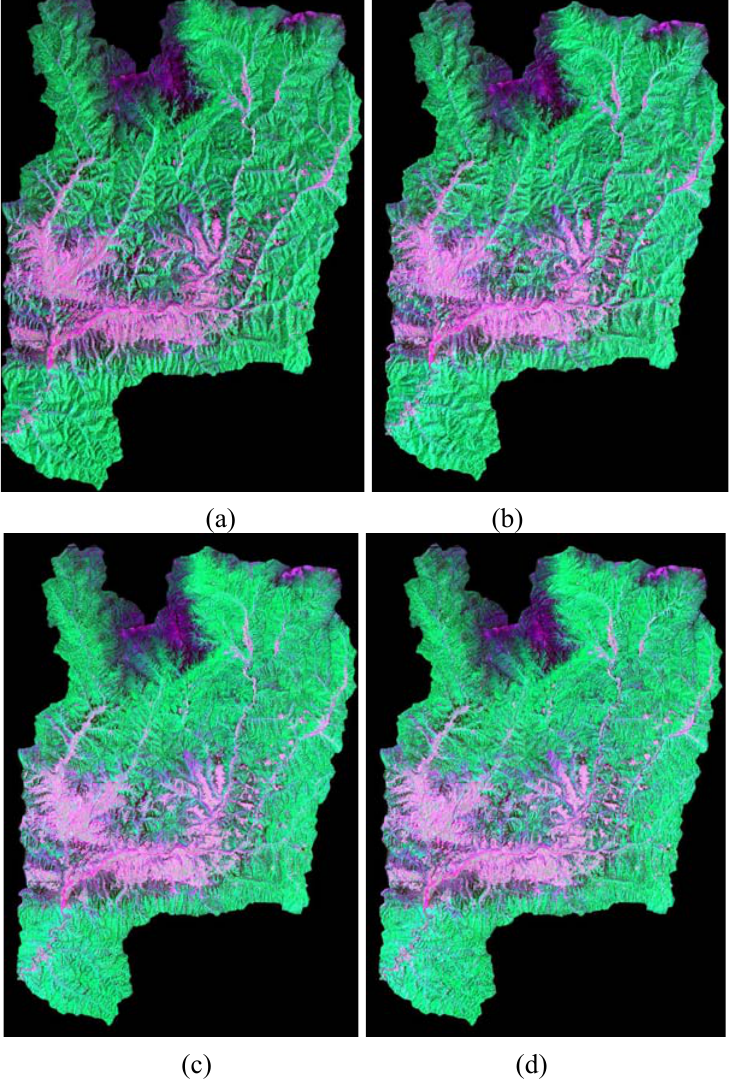
Figure 3. Comparison of color composite of RGB-543 Landsat-7 ETM+ image derived from two topographic correction methods being applied: (a) and (b) shows the image after SCS correction based on SRTM DEM and the DEM constructed from 1:50,000 scale topographic map respectively; (c) and (d) presents the image after Minnaert correction based on SRTM DEM and the DEM constructed from 1:50,000 scale topographic map